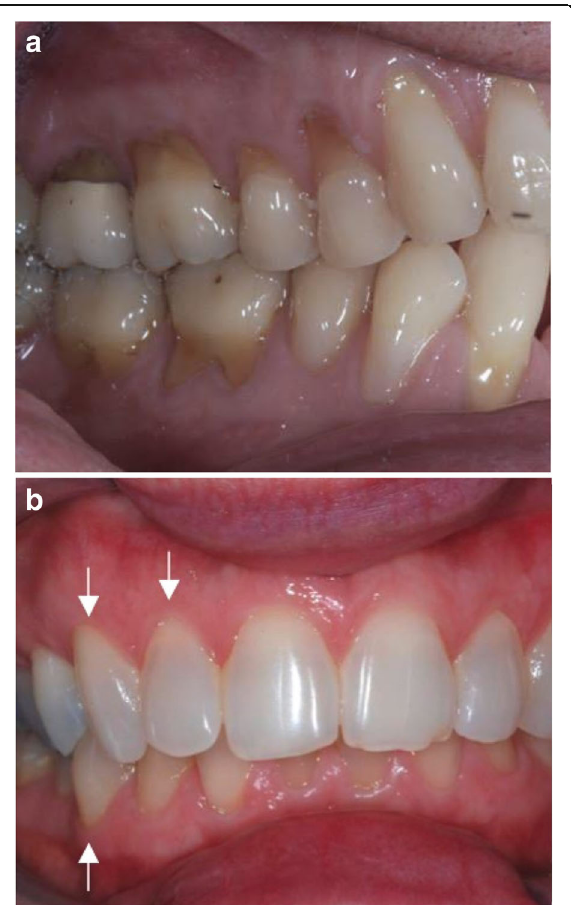
Fig. 3 a , b Patient with advanced gingival recession. In patients who are otherwise periodontally healthy the papillae maintains its normal position while the free gingival margin recedes, exposing the root cementum. b Patient with prodromal recession: Teeth with arrows don't how cemental exposure but show an increase in the gingival margin papillae